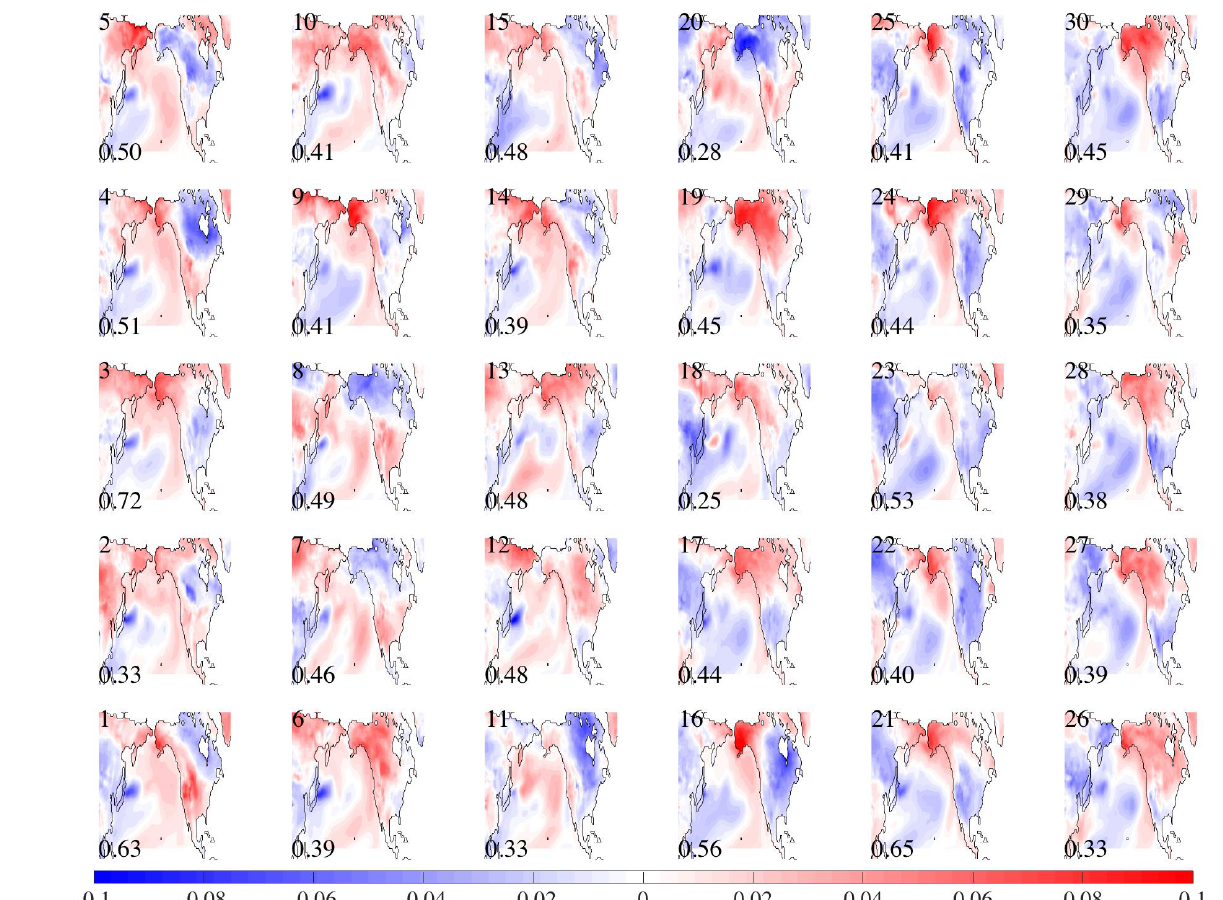
Figure 5. MCA between ocean temperature at 25m depth and land surface temperature. North Pacific Mode 1 for 30 simulations. Number in left-top corner is model number. The bottom-left-corner number is the percentage of covariance explained by pattern.